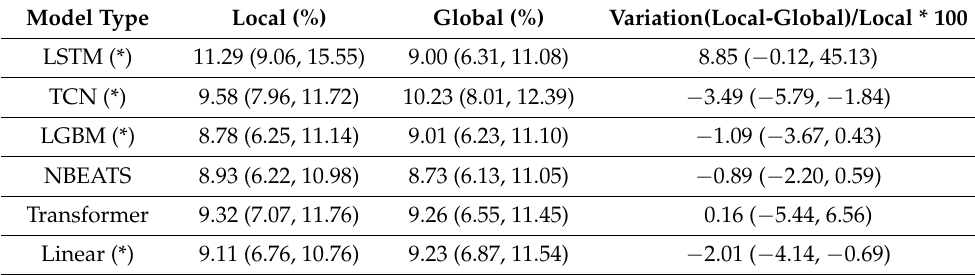
Table 2. In the table are reported the forecasting results of tested models in terms of median CV and the 25th and 75th percentiles (in parentheses). The Wilcoxon signed rank is used to test the null hypothesis that the paired CV samples for local and global models come from the same distribution. The (*) indicates that the null hypothesis was rejected for p -value < 0.05. The last column represents the variation in performance ( CV ) of a global model with respect to its local counterpart: if negative, the performance decreased.